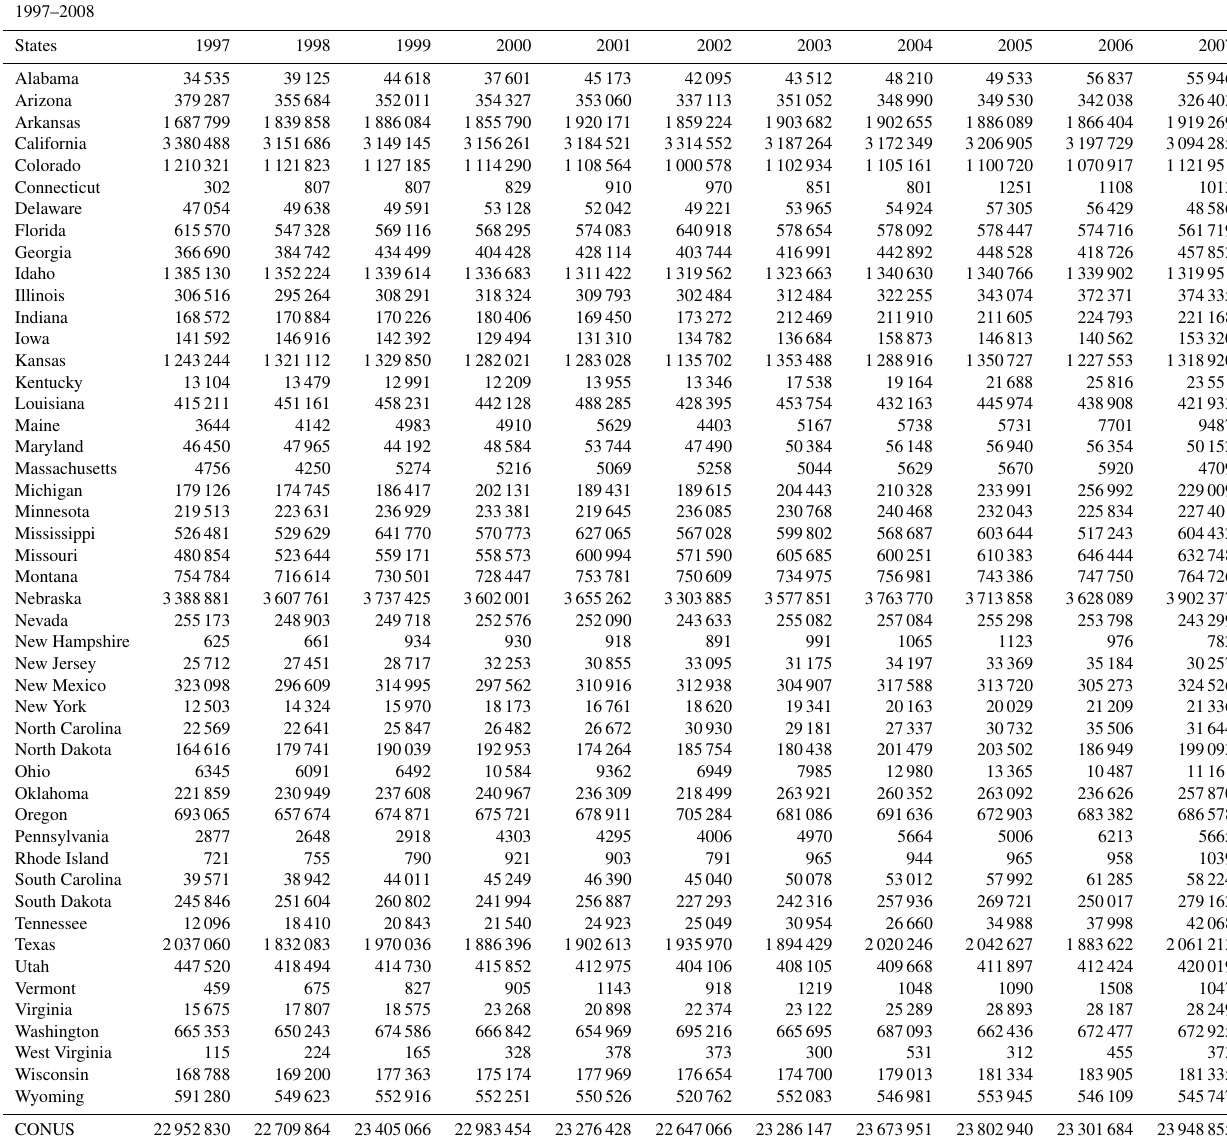
Table A1. The LANID-derived state-level irrigated area (in hectares) of each year between 1997 and